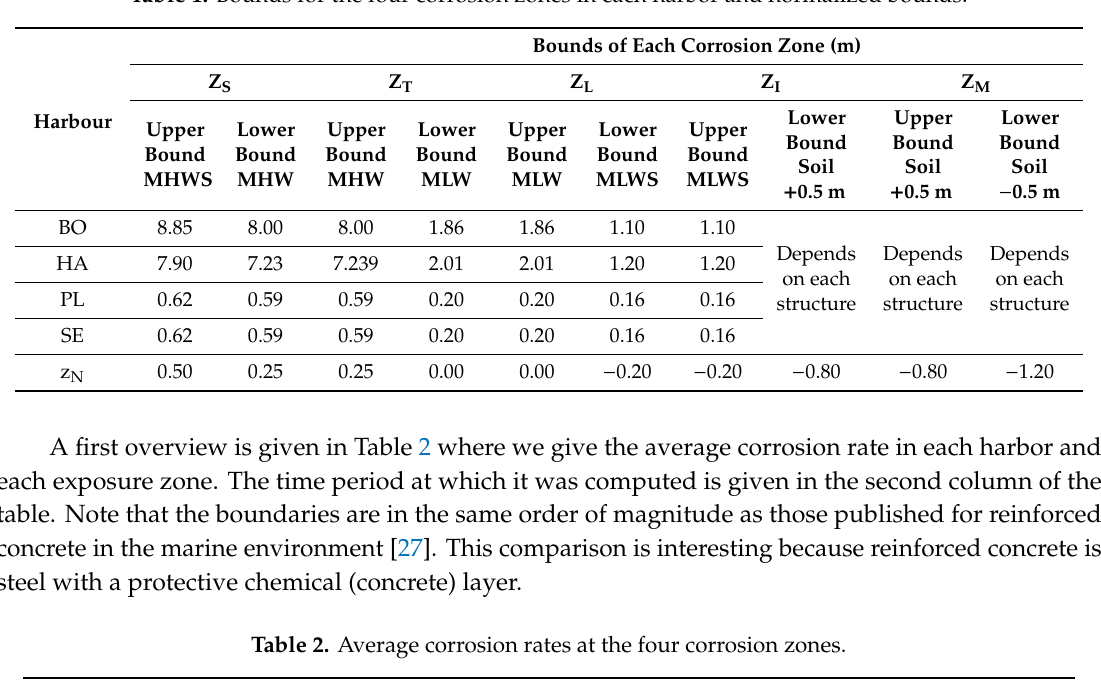
Table 1. Bounds for the four corrosion zones in each harbor and normalized bounds.